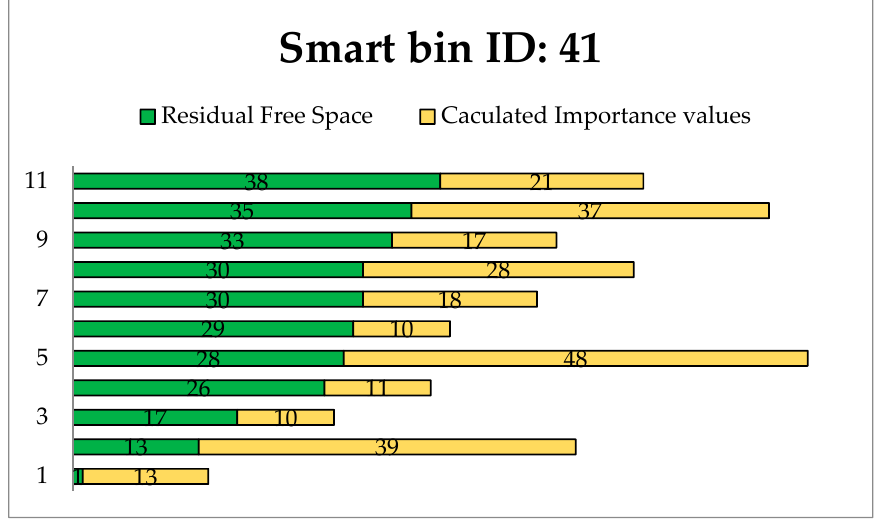
Figure 13. Evaluation routes to smart bin id: 41.